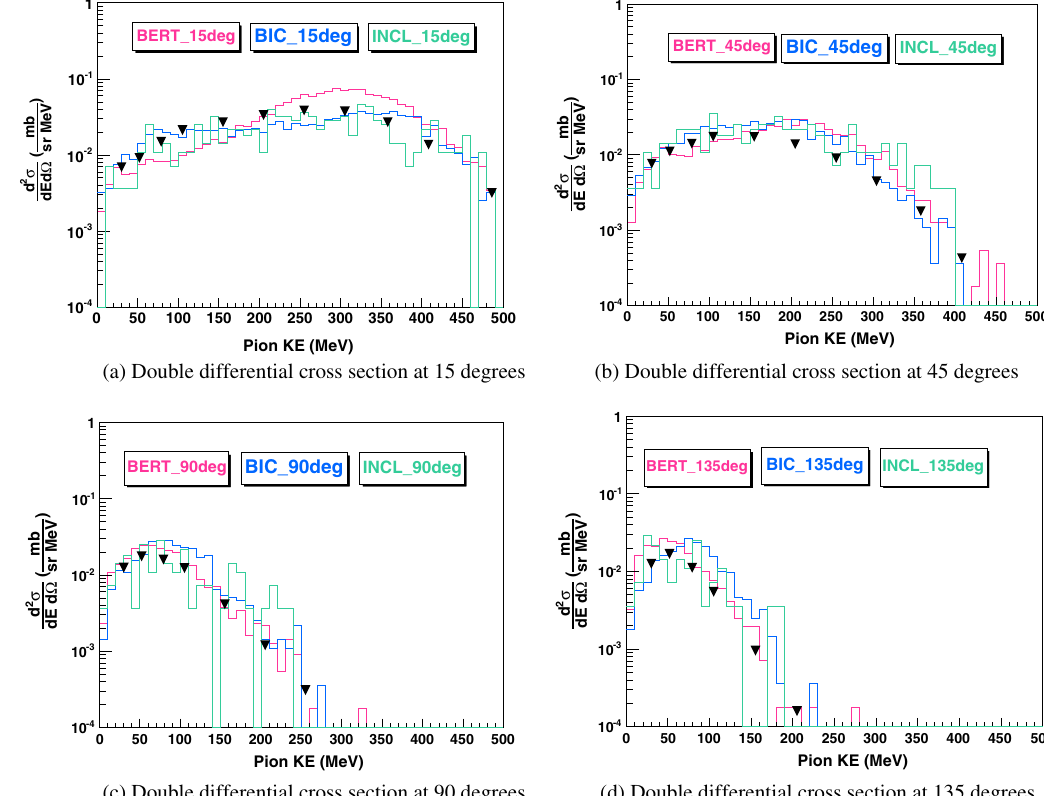
FIG. 3. Double differential cross section for positive pion production at 15, 45, 90, and 135 degrees with respect to the proton beam. Simulations using three physics lists (QGSP-BERT, QGSP-BIC, QGSP-INCL-ABLA) and experimental data are